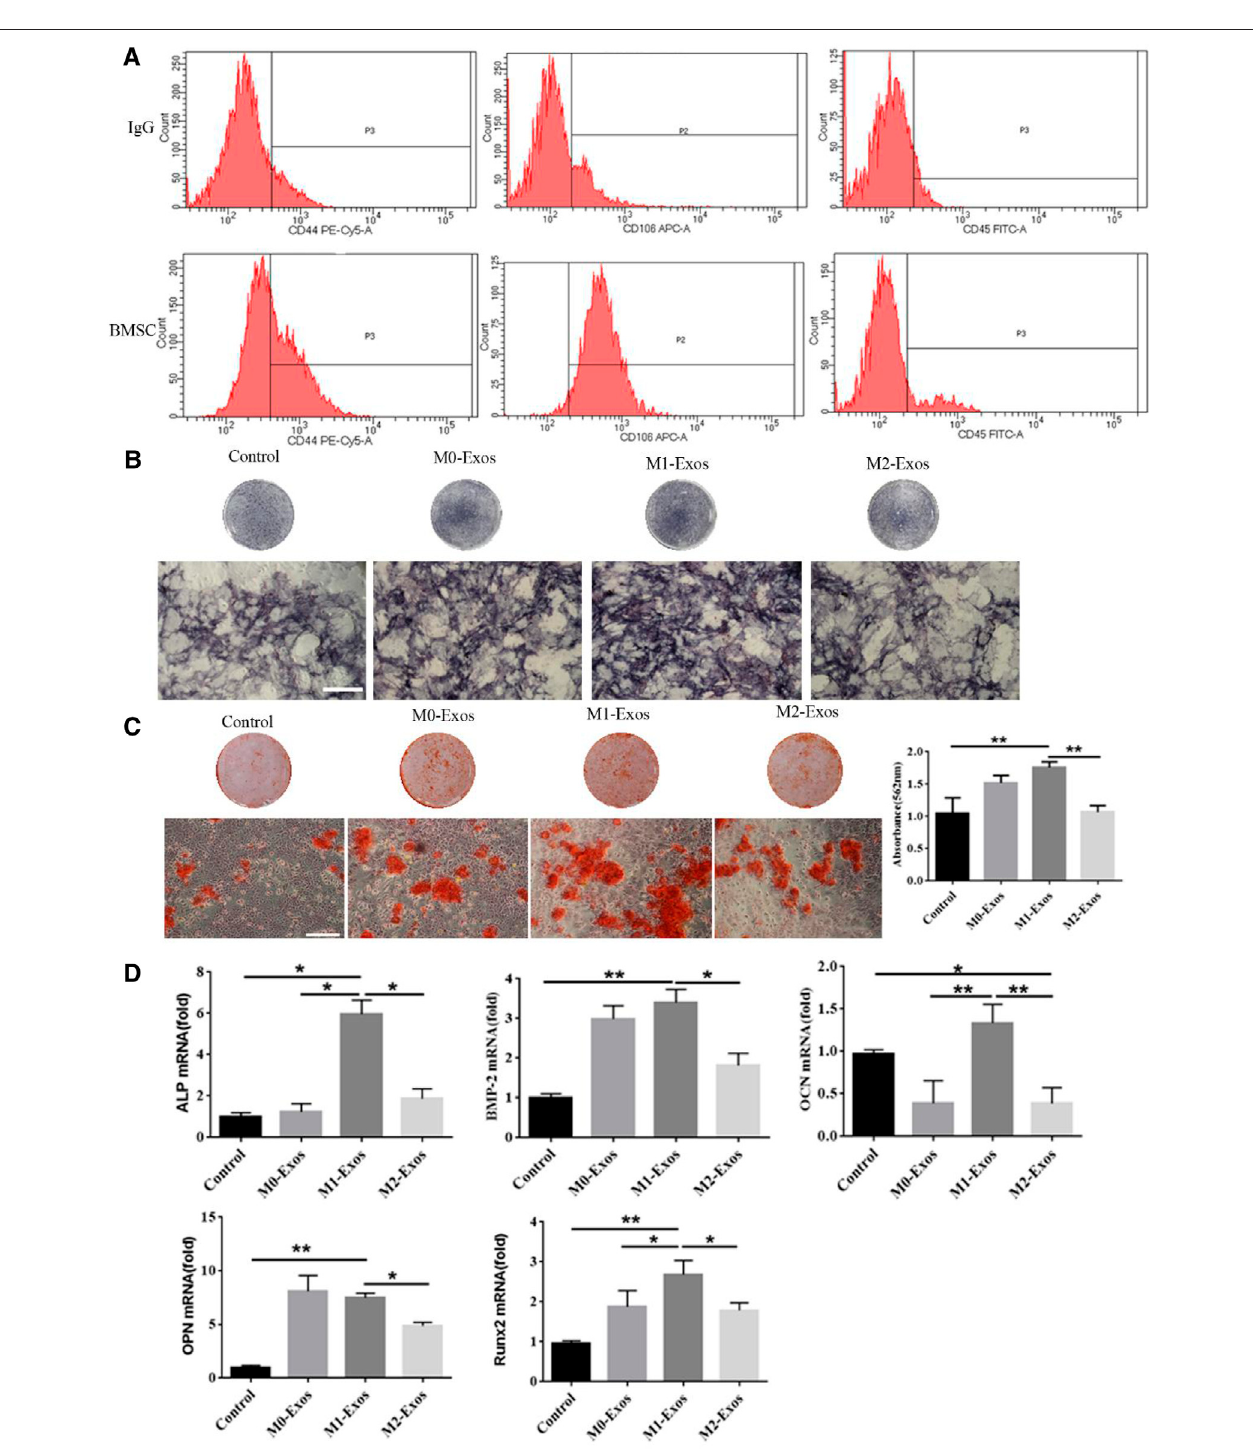
FIGURE 2 | M1-Exos promote osteogenic differentiation of BMSCs. (A) Identi fi cation of BMSCs markers by fl ow cytometry. (B) ALP stainingand in BMSCs (Scale bars,100 μ m). (C) AlizarinredSstainingandquanti fi cationinBMSCs(Scalebars,100 μ m); (D) TheexpressionofosteogenicgenewasdetectedbyqRT-PCR.Dataare presented as mean ± SD. * p < 0.05, ** p < 0.01 represent signi fi cant differences between the indicated columns.